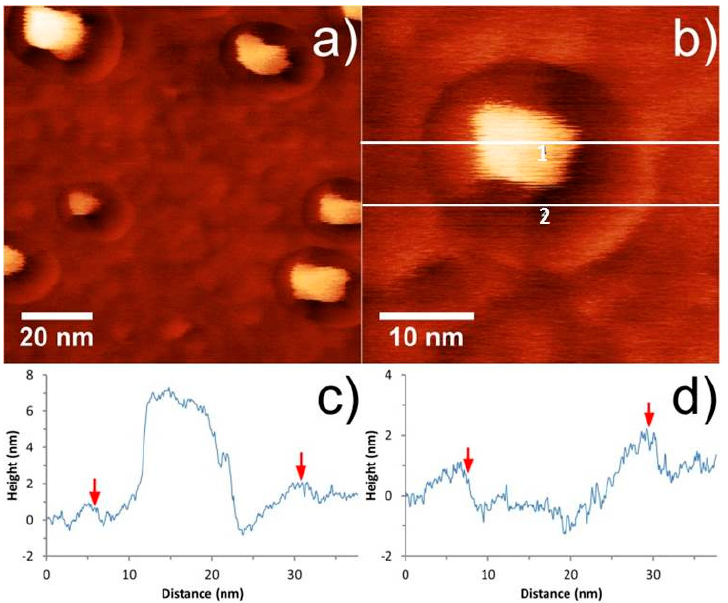
Figure 7. AFM images of gold nanoparticles on silicon using CNT1. ( a ) and ( b ) clearly showing the pit artefact with corresponding cross sections through the nanoparticle (line 1) and the pit (line 2). The edge of the pit, as observed by the AFM image, is indicated by the red markers in ( c ) and ( d ). The height or color scale for the image is 20 nm.